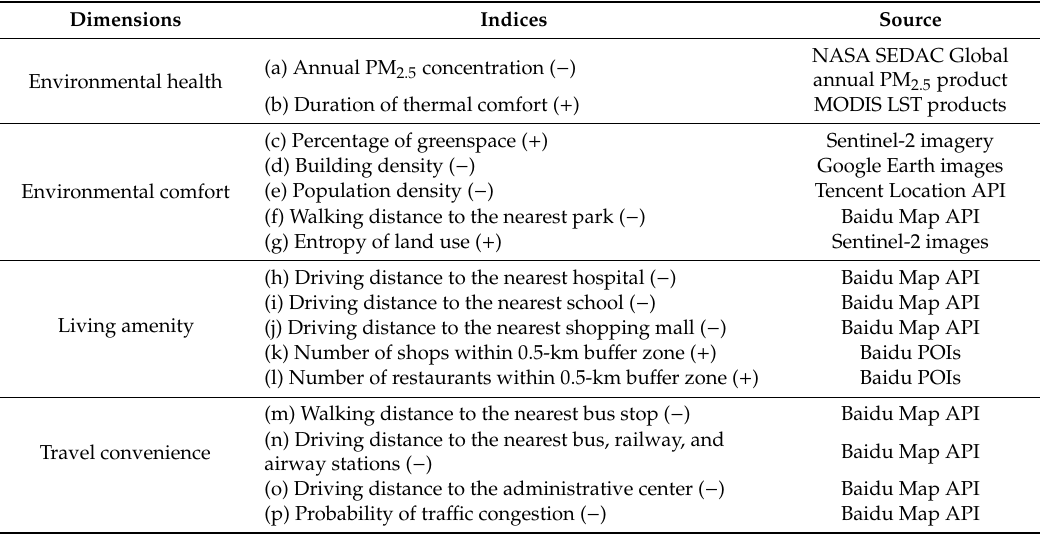
Table 1. A hierarchical index system for livability assessment which includes 4 dimensions at the top level and 16 indices at the bottom level. The positive sign indicates that the higher value of the index is more favorable to livability, and vice